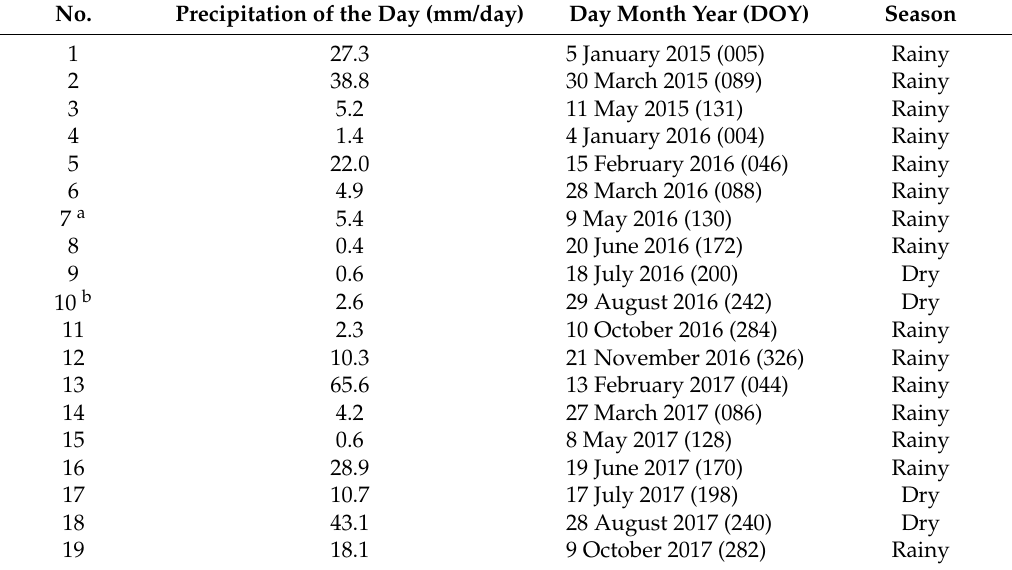
Table 1. List of phased array type L-band synthetic aperture radar (PALSAR)-2